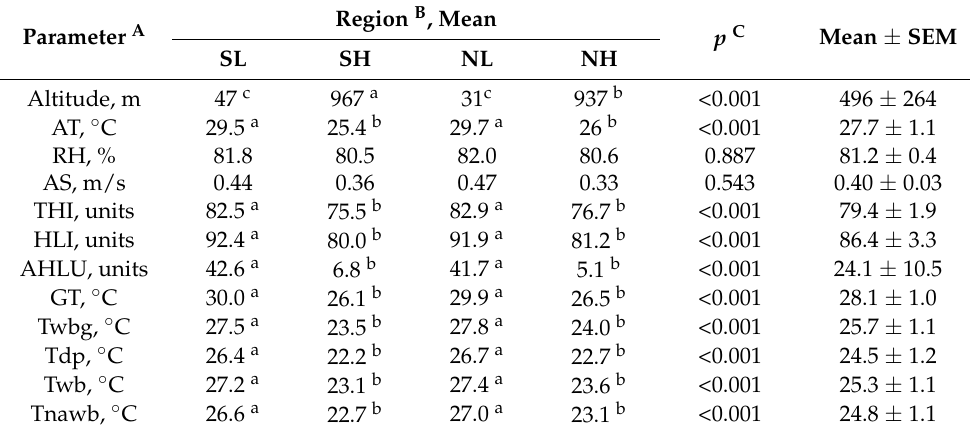
Table 3. Comparisons of altitude and microclimate parameters (averaging from 06:00 h to 18:00 h) inside the cowsheds between four dairy